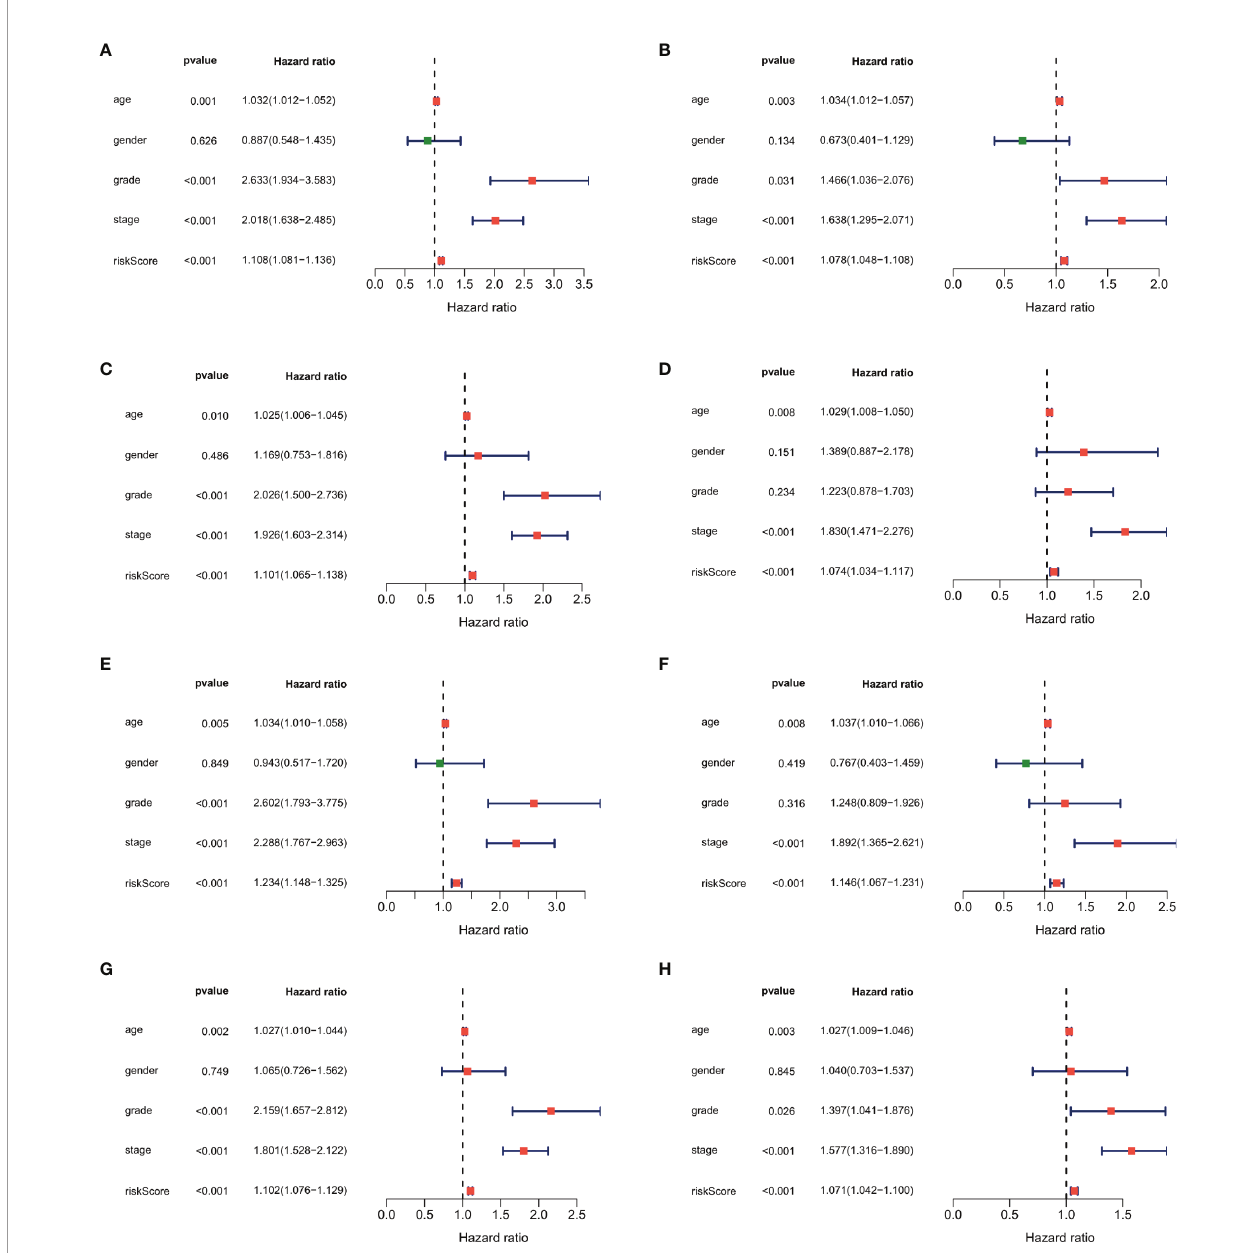
FIGURE 6 | Forest plot of the univariate and multivariate Cox regression analysis showing that the risk score was an independent risk factor for overall survival in the training dataset (A, B) , 1 st validation dataset (C, D) , 2 nd dataset (E, F) and the 3 rd validation dataset (G, H)